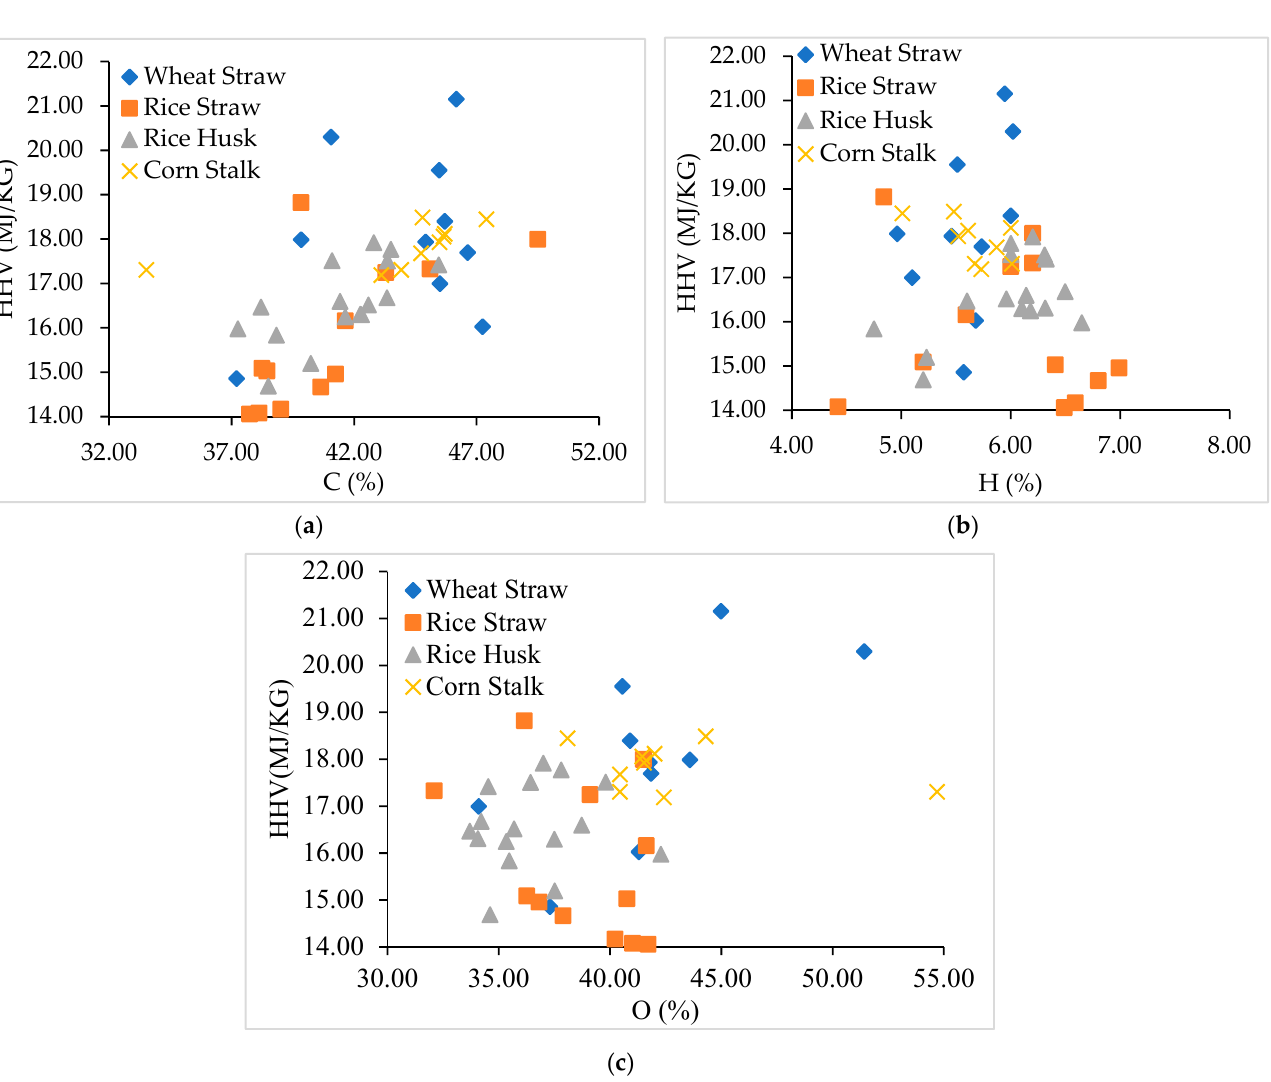
Figure 2. Relationship between ultimate analysis composition and HHV ( a ) C content, ( b ) H content, and ( c ) O content.